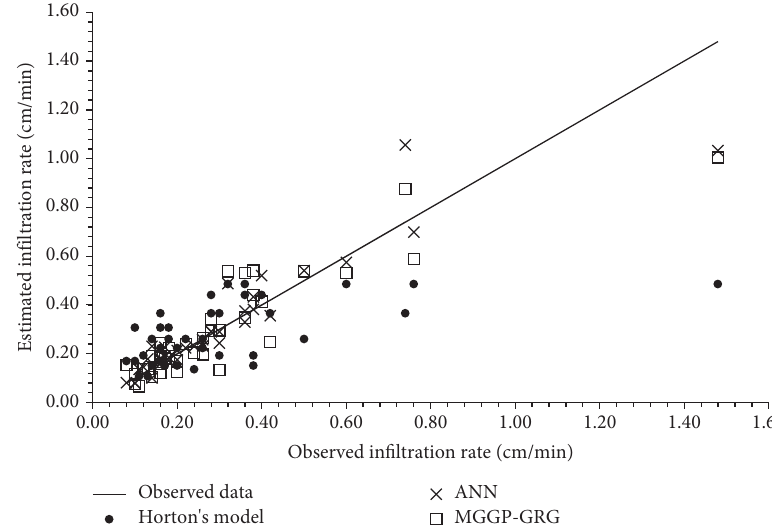
Figure 12: Estimated versus observed infiltration rates during the testing phase.